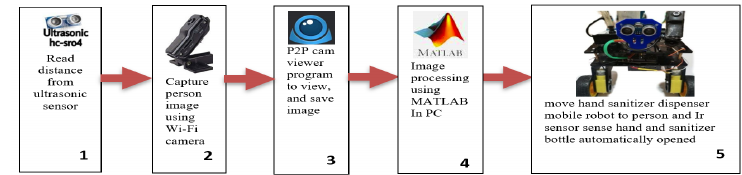
Fig. 4. The proposed block diagram of a touchless hand sanitizer dispenser mobile robot